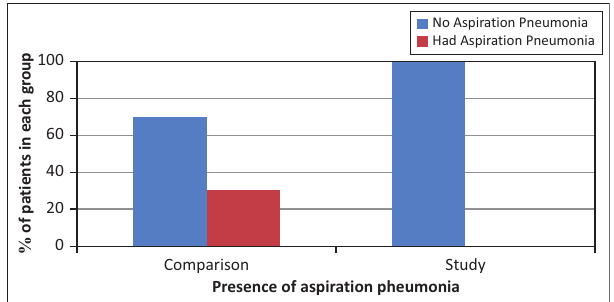
FIGURE 4: Presence of aspiration pneumonia within the study and comparison